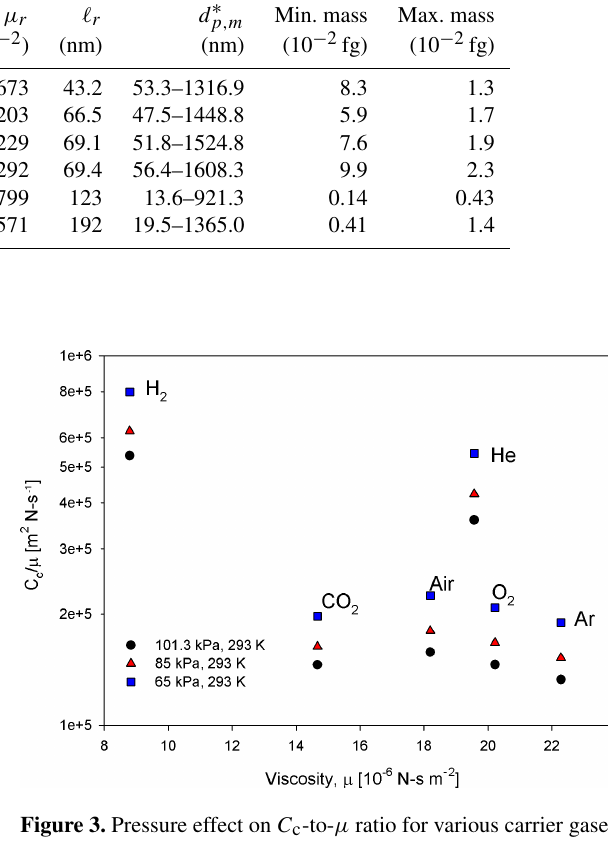
stream CPC (condensation particle counter, TSI 3022A)